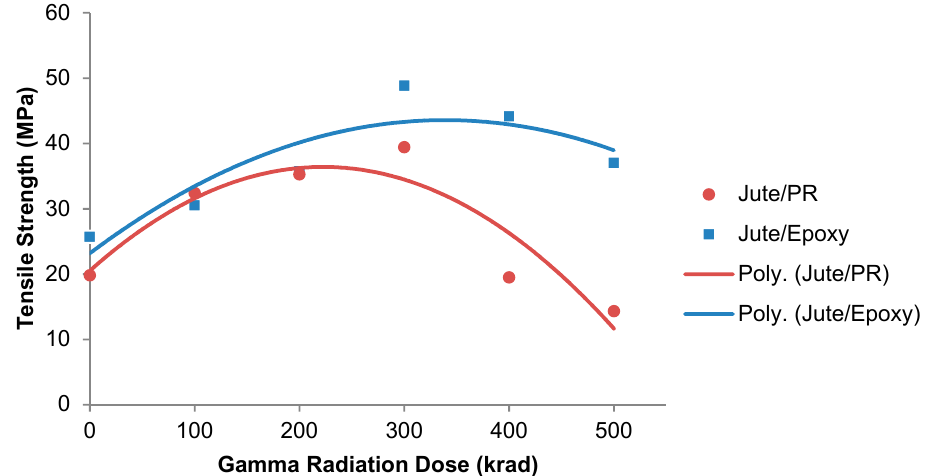
Figure 3. Gamma radiation effects on the tensile strength (TS) of the Jute/PR and Jute/Epoxy composites.